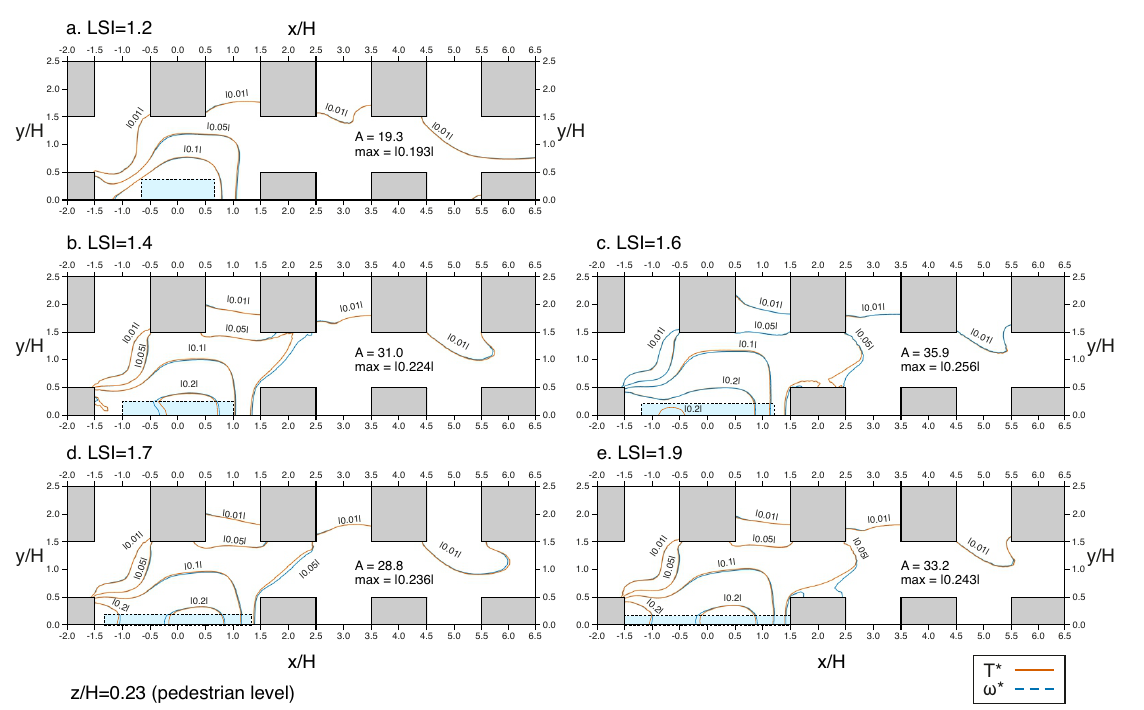
ω*z/H=0.23 (pedestrian Figure 19. Contours of normalised temperature ( T ∗ ) and water vapour concentration ( ω ∗ ) over a horizontal plane at pedestrian level ( z / H = 0.23) for the cool water body cases ( ∆ T = − 2 K) and different shapes: ( a ) LSI = 1.2; ( b ) LSI = 1.4; ( c ) LSI = 1.6; ( d ) LSI = 1.7; ( e ) LSI = 1.9; results of the original LSI = 1.1 case can be found in Figure